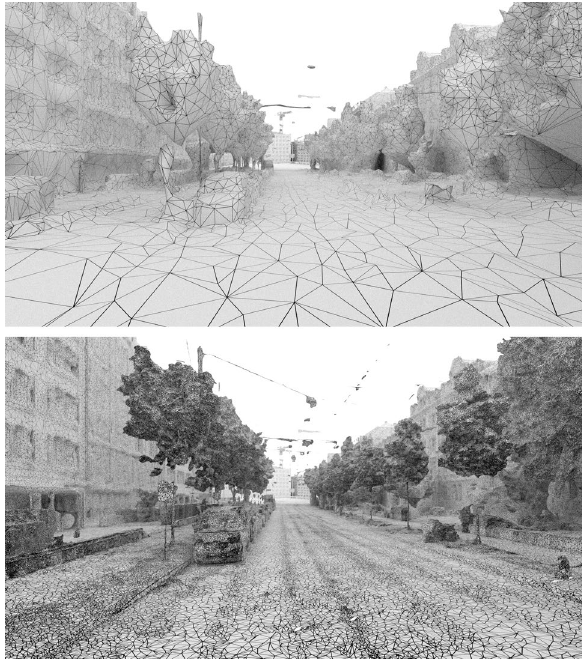
Figure 14. Edged faces renderings of different 3D models of identical sub-scenes at street level. Top: reconstruction using Figure 16. Size comparison example : the same mesh portion of only UAV imagery, bottom: reconstruction using UAV and different reconstructions 260x170m. Up: UAV-based mesh: 1.3 MMS imagery. million polygons / 650 K vertices. Bottom: UAV+MMS-based mesh: 10.5 million polygons / 5.3 million